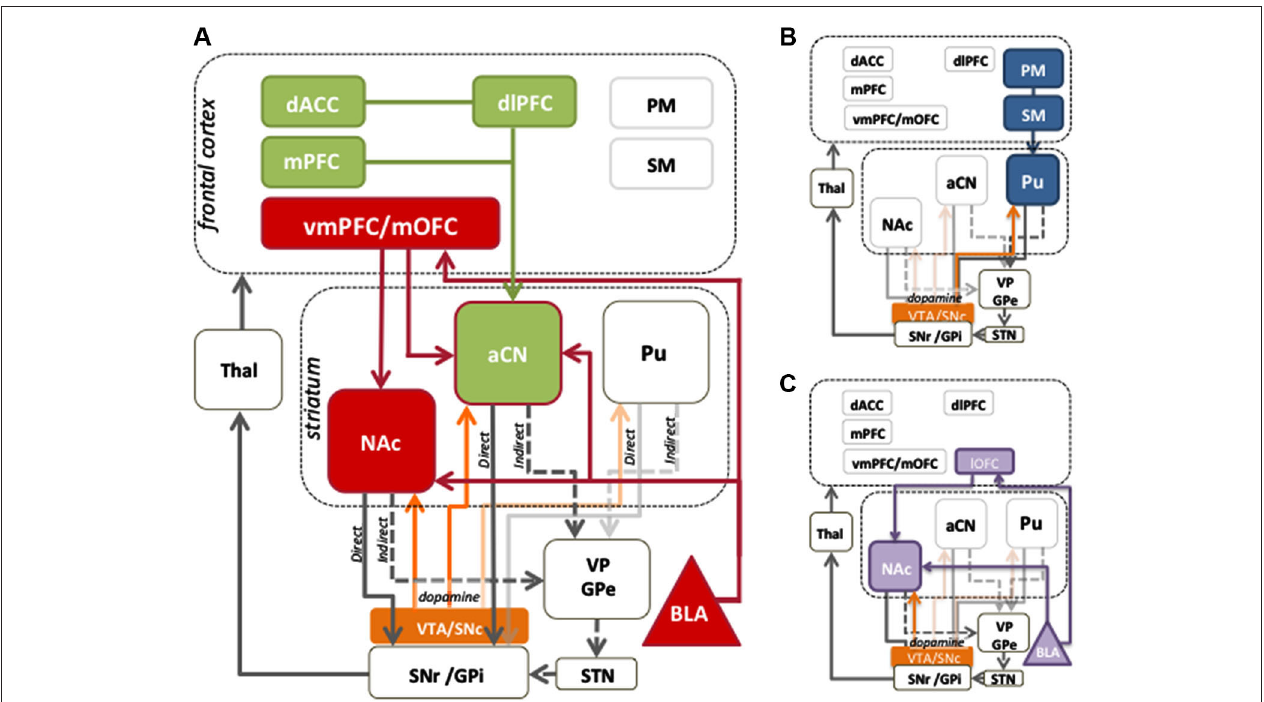
over circuits involving prefrontal and aCN activity. Together, the contingency and evaluative circuits allow for the acquisition of goal-directed behaviors. (B) Stimulus-response associations, or habits, are mediated by projections from premotor (PM) and sensorimotor cortices (SM) to the posterior putamen (Pu). (C) The lateral orbitofrontal cortex (lOFC) and the BLA encode the value assigned to reward predictive stimuli, which the NAc uses to mediate instrumental performance. Mid-brain dopamine modulates plasticity in the dorsal striatum, and is associated with motivational processes in the ventral striatum. The balance between striatal output to the direct (D1) and indirect (D2) pathways serves to promote or inhibit behavior,